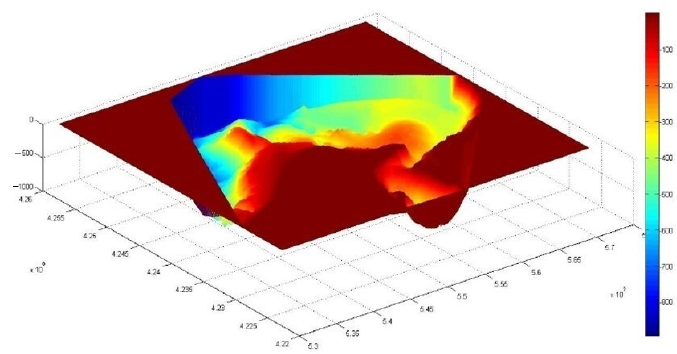
Figure 10. Three-dimensional plane view of meshgrid interpolating bathymetric data.